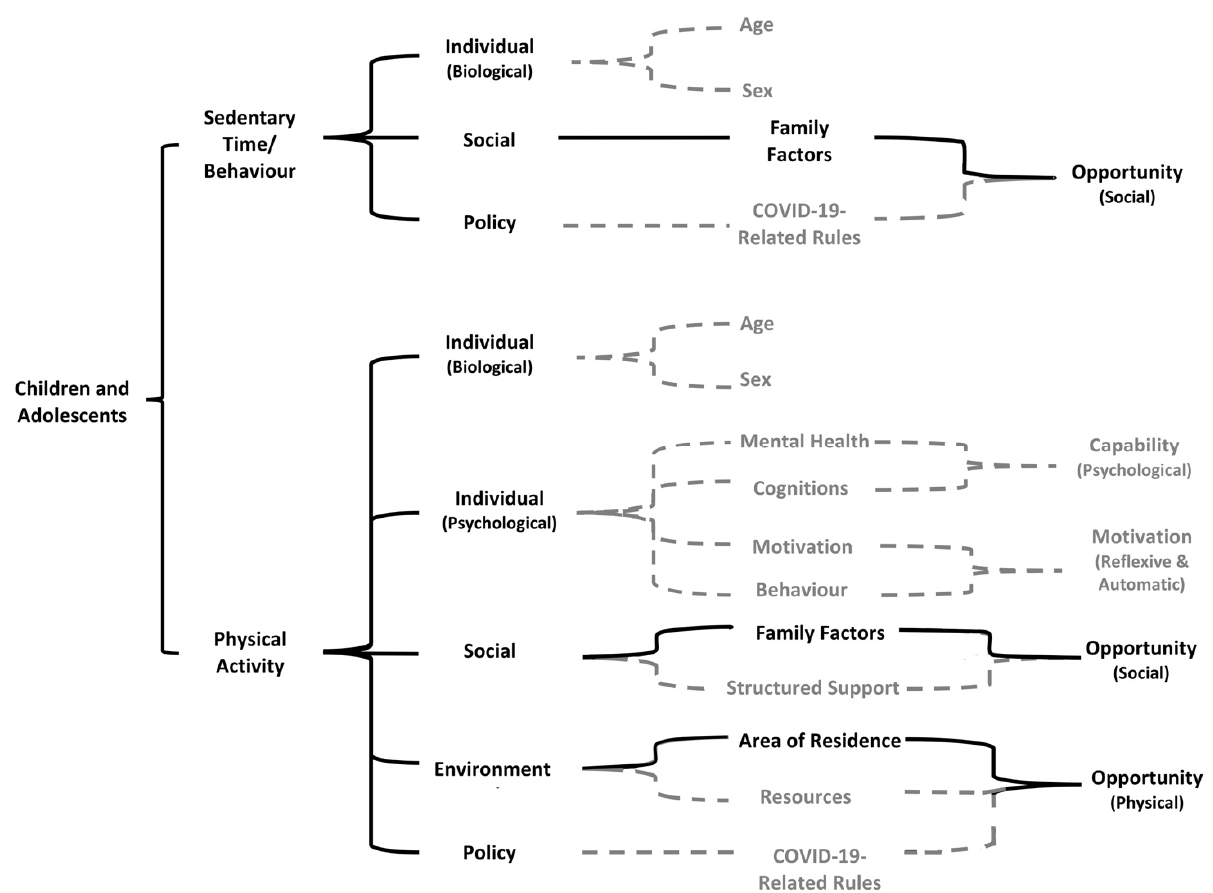
Figure 2. Socioeconomic model of correlates of PA and sedentary time/behaviour during the COVID-19 restrictions. Solid lines reflect the correlates and pathways for which the strongest evidence was identified, whilst those shown with dashed lines indicate those pathways and correlates with weaker evidence.